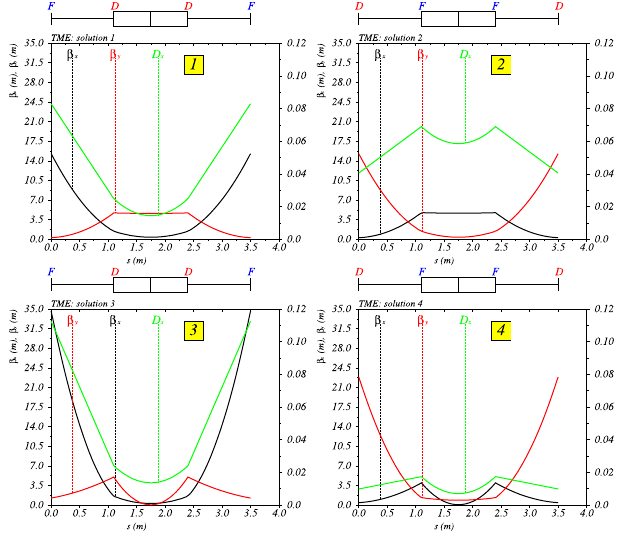
FIG. 2. Four periodic optical solutions for the cell from Fig. 1. F and D stand for focusing and defocusing quadrupole, respec- tively. Solution 4 provides minimum emittance